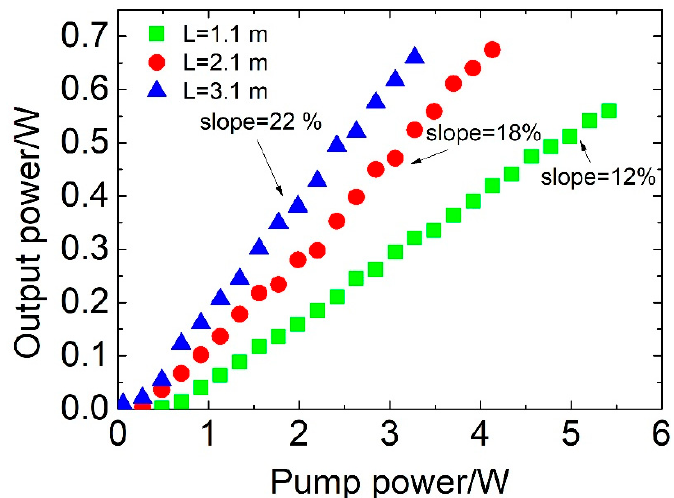
Figure 2. Output power of an Er 3+ :ZBLAN fiber laser as a function of the pump power for different fiber lengths. The AOM was switched off (transmission >95%).